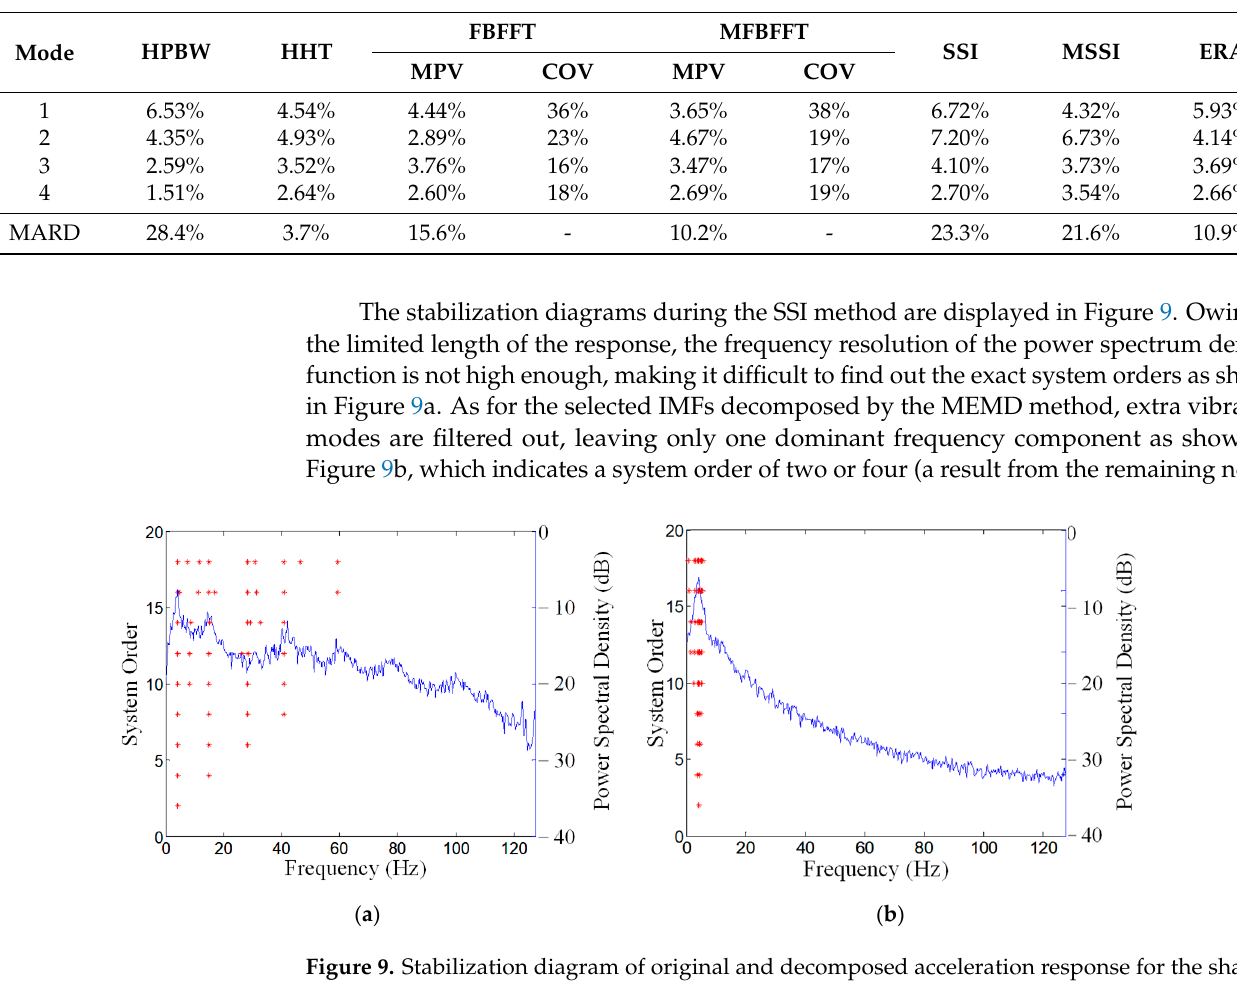
Table 5. Identified results of the damping ratios for the shaking table test.